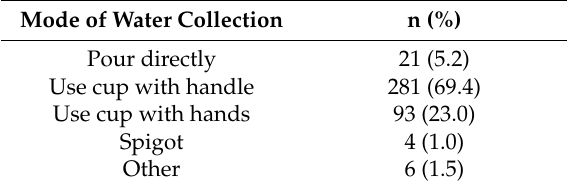
Table 3. Mode of water collection from storage containers.